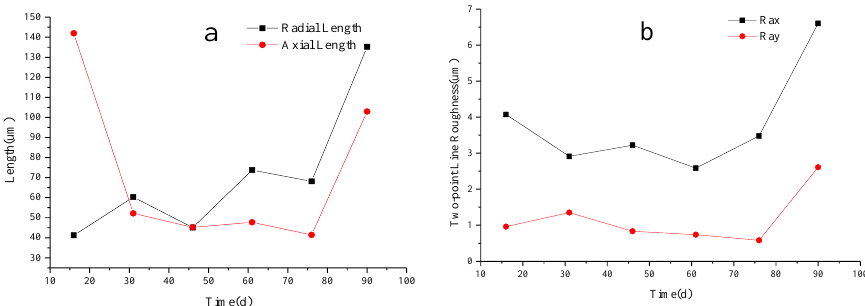
Figure 17. Micro-structure of a wheat stalk over time with wet rotary tillage. Note: ( a ) Changing of radial and axial length over time with wet rotary tillage, ( b ) Changing of R ax and R ay over time with wet rotary tillage.